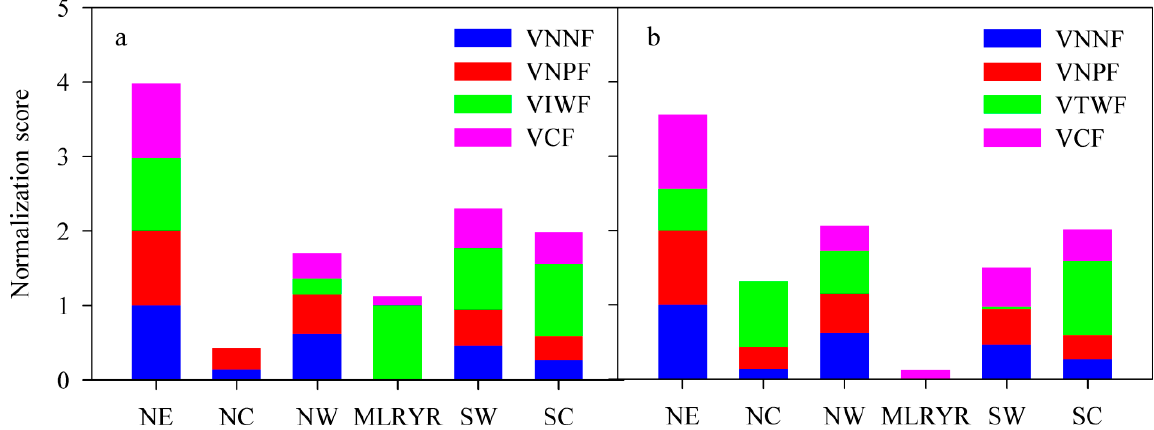
Figure 6. The normalization score of the six potato cultivation regions based on VNNF, VNPF, VIWF, and VCF indicators ( a ), and VNNF, VNPF, VTWF, and VCF indicators ( b ).